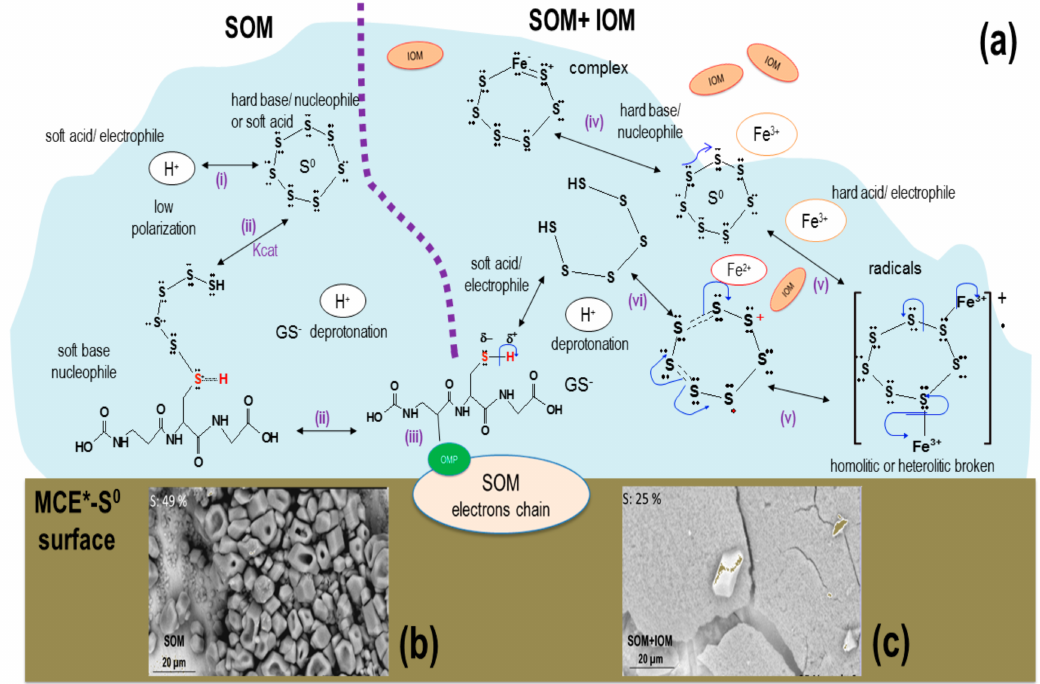
Figure 5. Proposed model of S 0 (bio)oxidation by A. thiooxidans alone or with the IOM, Leptospirillum sp. ( a ) (i) Cyclic S 0 behaves as a hard base; thus, the presence of H + , is not sufficient to favor a reaction affinity. (ii) Although the deprotonated glutathione (due to the acid medium) GS- acts as a soft and nucleophilic base and may form GS-S n H, it has been reported that K cat for this reaction is very low. (iii) GS-S n H is transported to the SOM periplasm via the outer membrane protein (OMP). The GSH catalyst is regenerated. In the presence of IOM, S 0 as a hard-base shows affinity for the produced Fe 3+ that is also a polarizing agent. Thus, Fe 3+ may induce a S 0 -Fe 3+ complex formation and/or (iv–vi) charge delocalization, until it rises to a linear S n 2 − that interacts with the GS − to form GS-S n H, available for SOM, as already mentioned (iii). Agglomerated reduced sulfur species (RSS) ( b ) and